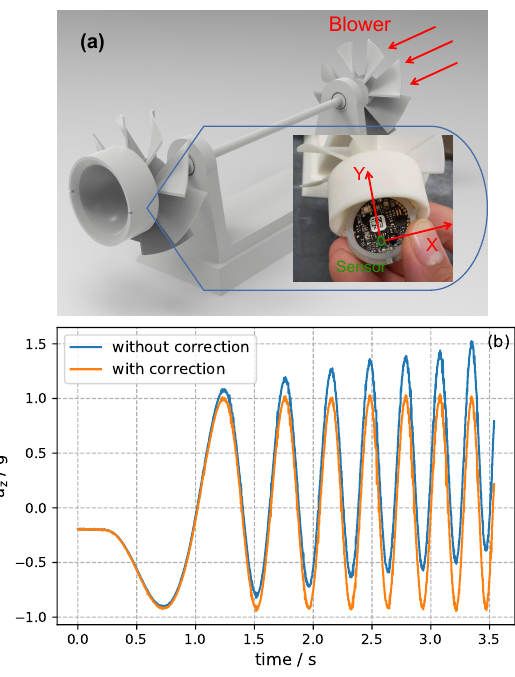
Figure 2. (a) A horizontally rotating shaft with projectile mounted on one end for the calibration of sensor position with respect to the center of the projectile. (b) A comparison of pro- jectile acceleration in the vertical direction obtained with and without centrifugal and Euler acceleration (i.e., a c )